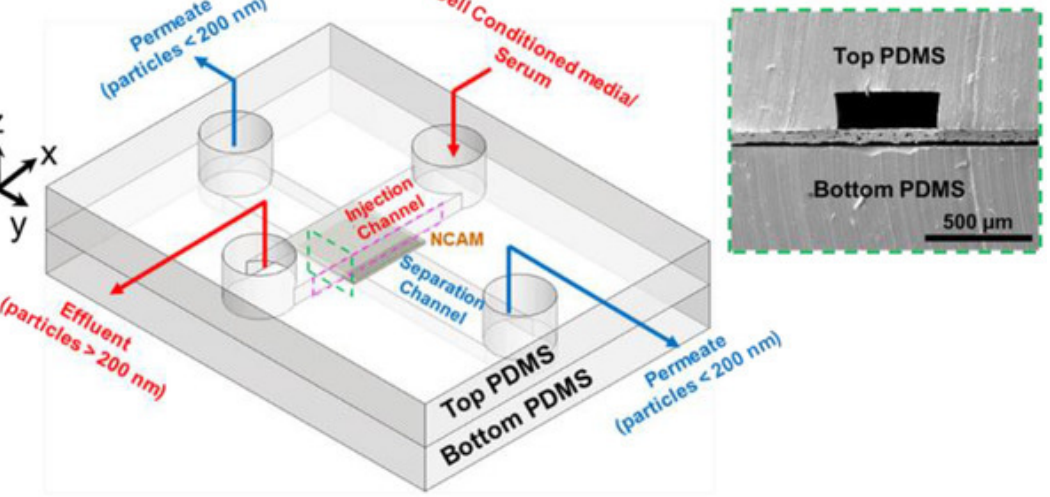
Figure 5. Schematic of Casadei et al. microfluidic filtration device consisting of perpendicular injection and separation channels separated by a nanocapillary array membrane (NCAM). Figure used with permission from [96] .